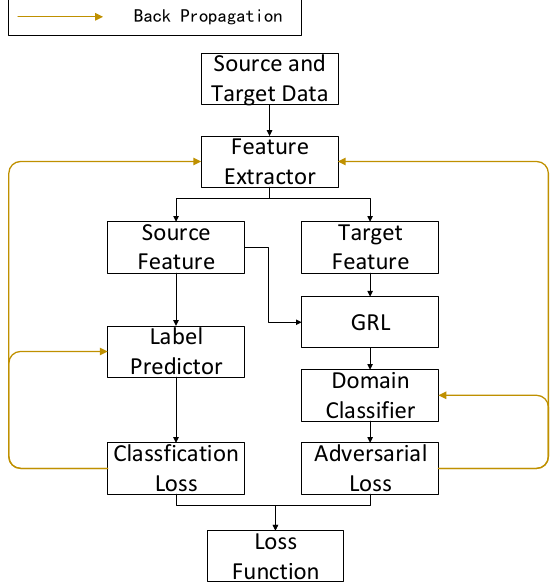
Figure 2. DANN training